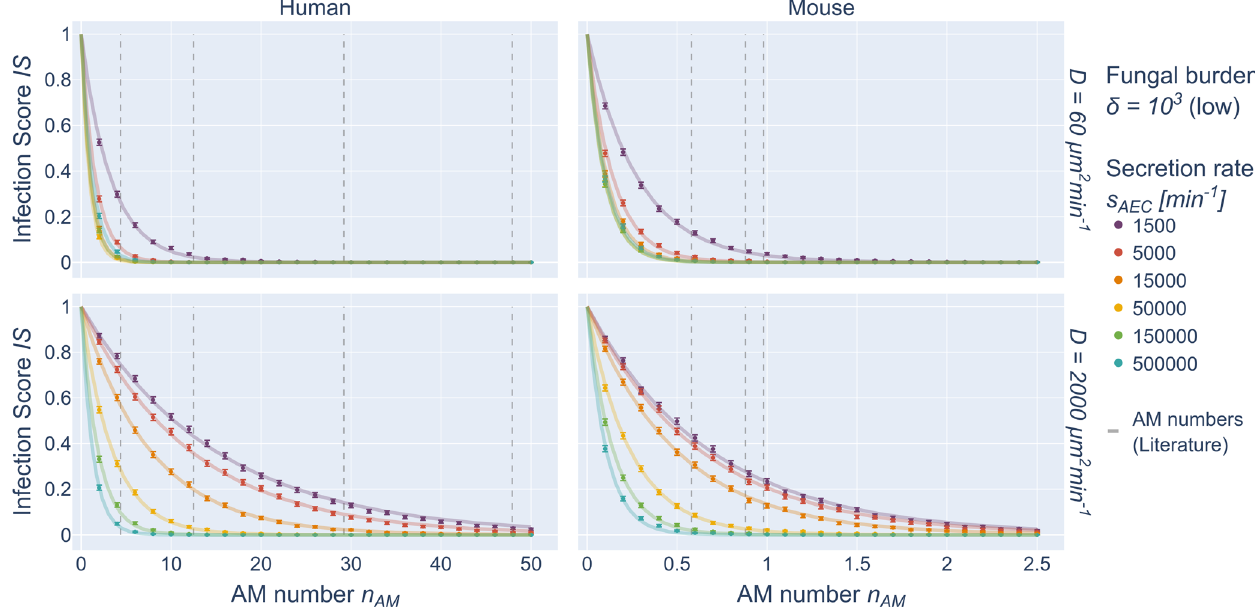
Fig. 2 hABM simulation data and SIM predictions for low fungal burden. Simulated data from the hABM are shown as points for low fungal burden in the human (left) and murine (right) system for D = 60 µm 2 /min (top row) and D = 2000 µm 2 /min (bottom row). Error bars represent the 95% con fi dence interval as obtained from the standard error of independent Bernoulli trials. Solid lines represent the fi t to the data points as obtained by the Weibull survival model (WSM). Dashed vertical lines denote AM numbers from